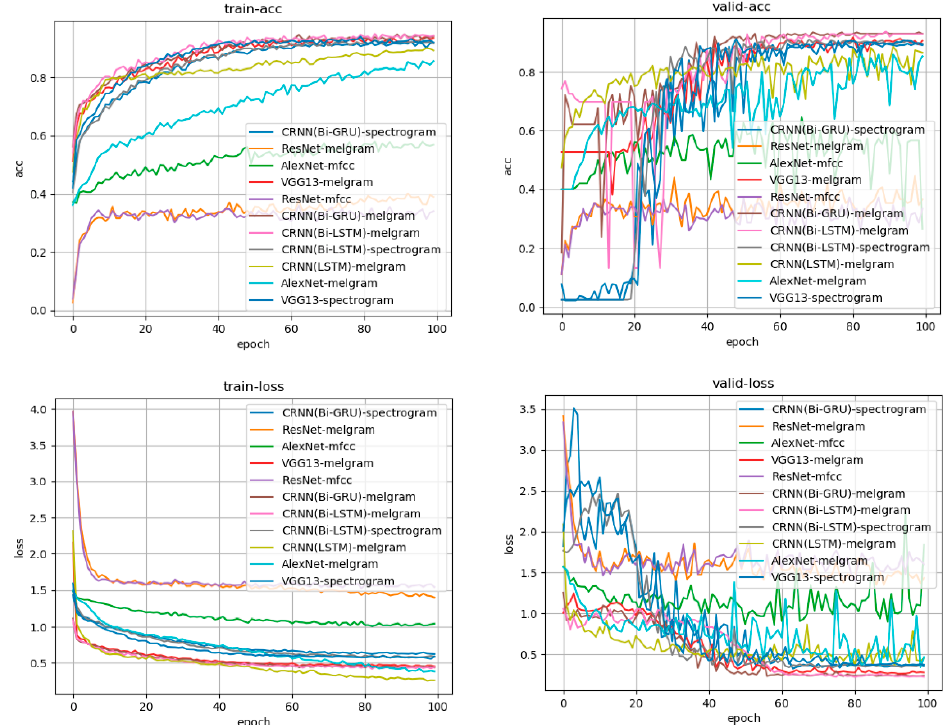
Figure 3. Learning curve for each learning model and each input source. Accuracy is presented in the upper row, whereas the loss is in the lower row. The left side is the transition based on the training data, and the right side is the transition based on the verification data. The horizontal axis indicates the number of times of learning, and accuracy increases as learning progress. Loss represents the difference between the answer of the input data predicted by the model during the learning process (e.g., the degree of firing that is a high tone) and the teacher’s answer to the actual input data (the high tone is the correct answer). It can be observed that the difference between the answer and answer from the learning model obtained during learning has decreased. The CRNN:Bi-GRU model, which had the mel-frequency log spectrogram as input, was the learning model with good accuracy and loss in both training data and verification data.